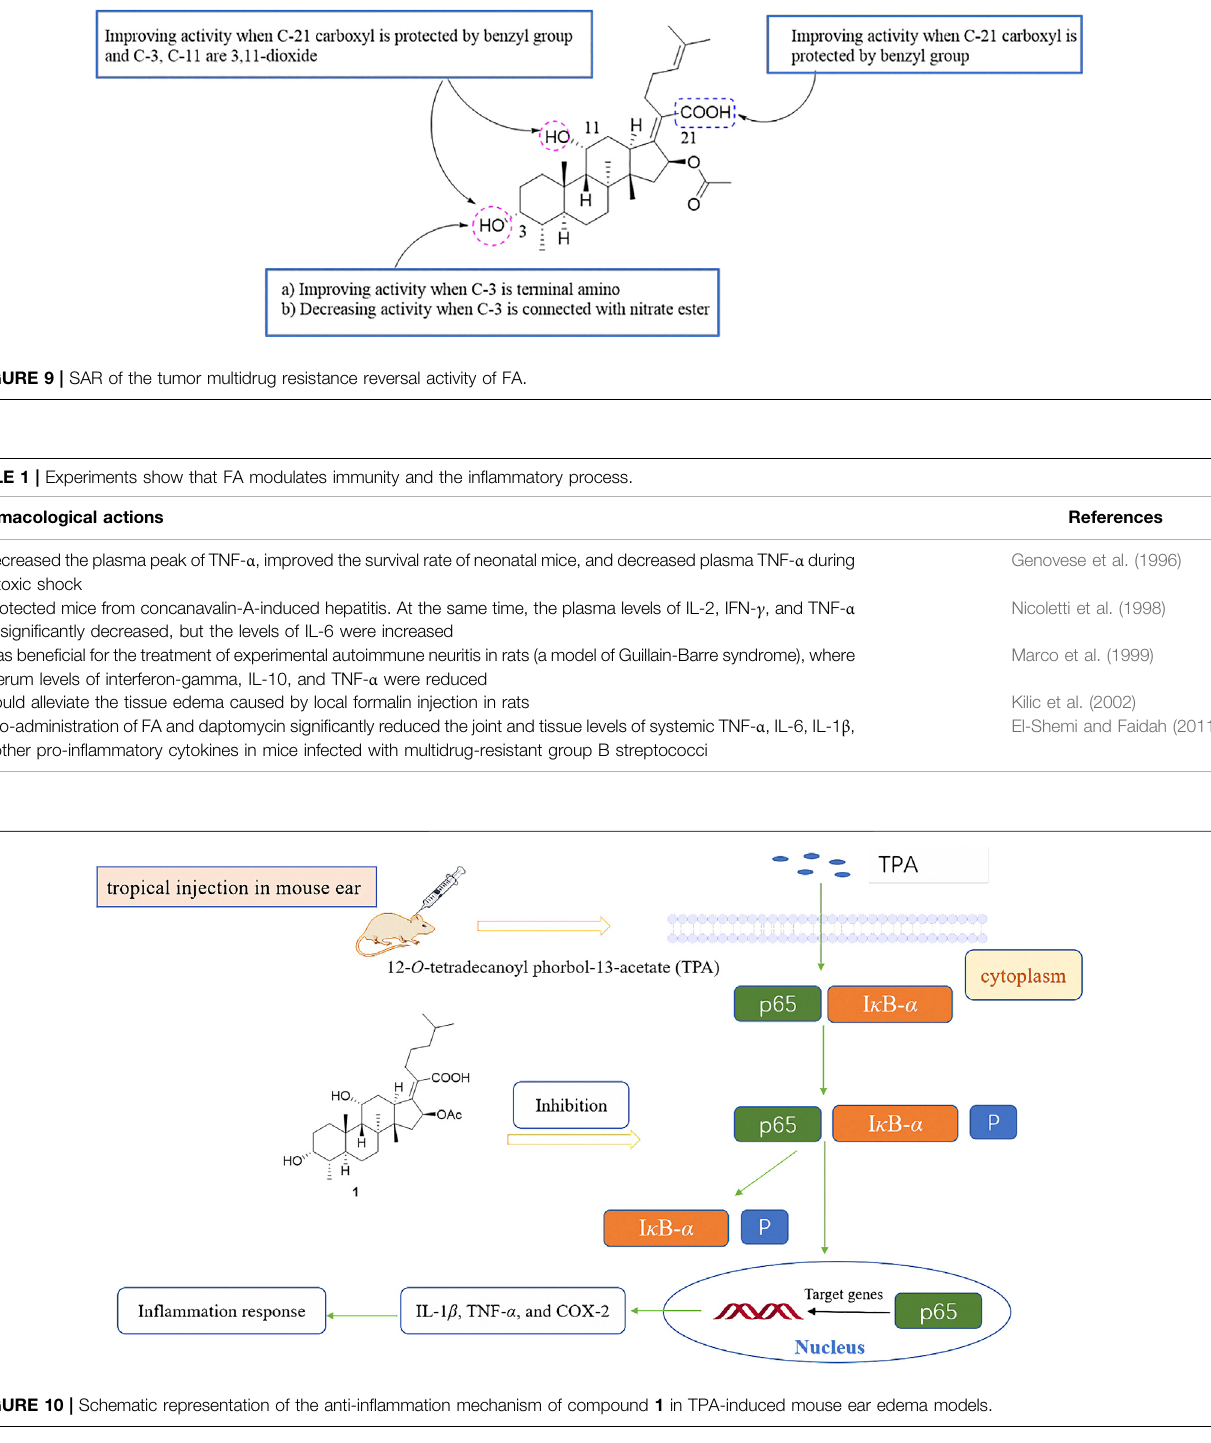
Frontiers in Pharmacology |